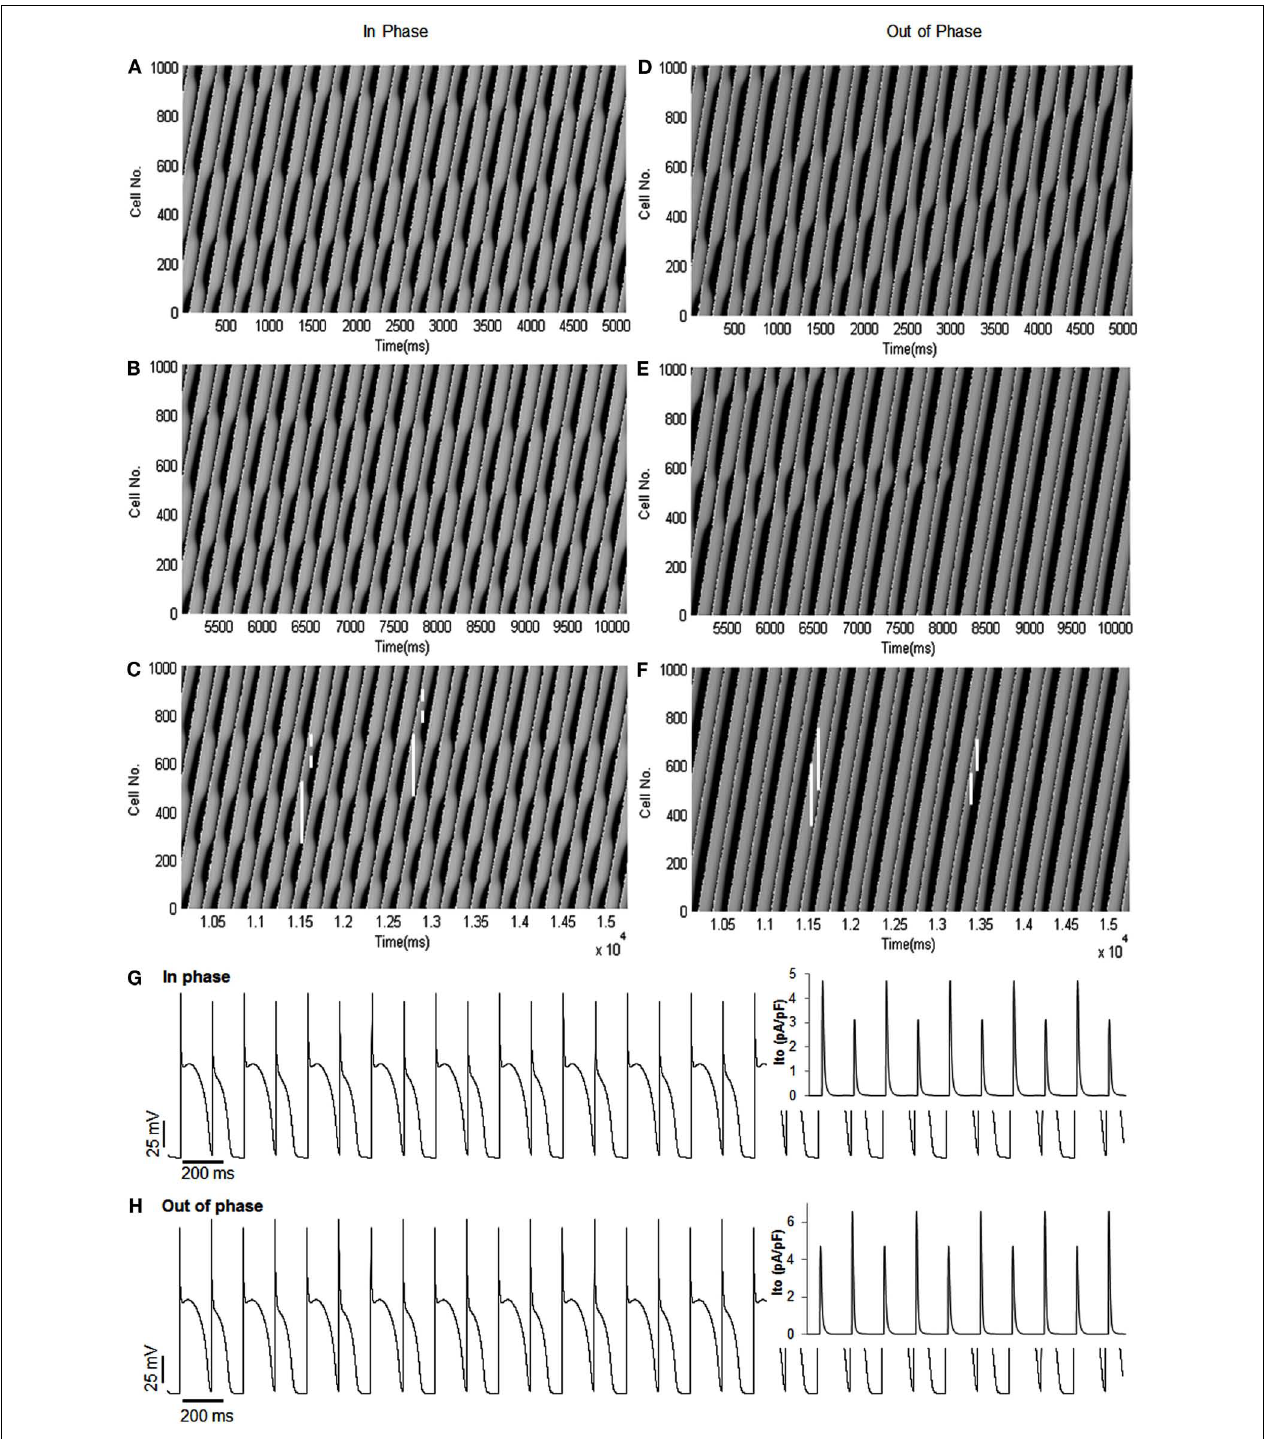
|d v /d t | max with APD alternans.The figure shows that the discordant alternans produced by the initial conditions were removed progressively by the out of phase relationship, and concordant alternans persisted along the tissue afterward. Compared to (A–C) , the change in wavelength was minimal. (G,H) Show theTMP traces at the paced cell (cell 5) for the last 30 beats, corresponding to (C,F) , respectively. In [ (G,H) ; inset] are traces of I to current for the last 10 APs which show that, as expected, I to mimics changes in |d v /d t | max .